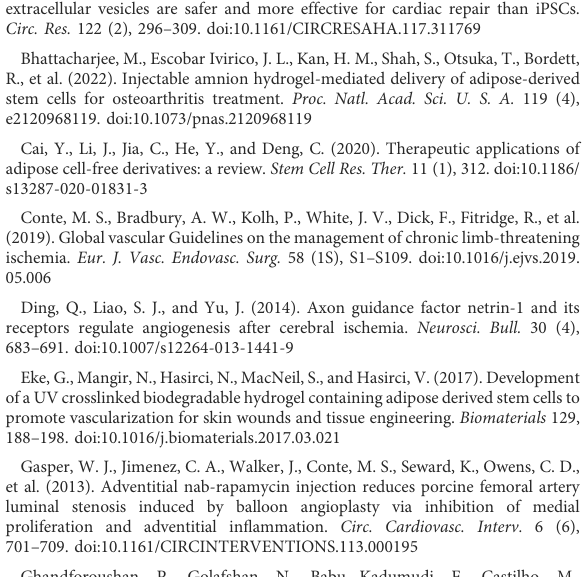
carotid artery of rats. (B) Rats were sacri fi ced 14 days after operation and bilateral carotid arteries were isolated. SUPPLEMENTARY FIGURE S4 Relative media thickness, a supplement to Figure 6A. * p < 0.05. SUPPLEMENTARY FIGURE S5 Immuno fl uorescence staining of CD31 (red) and α -SMA (green) depicting endothelial integrity of control group (no injury and no